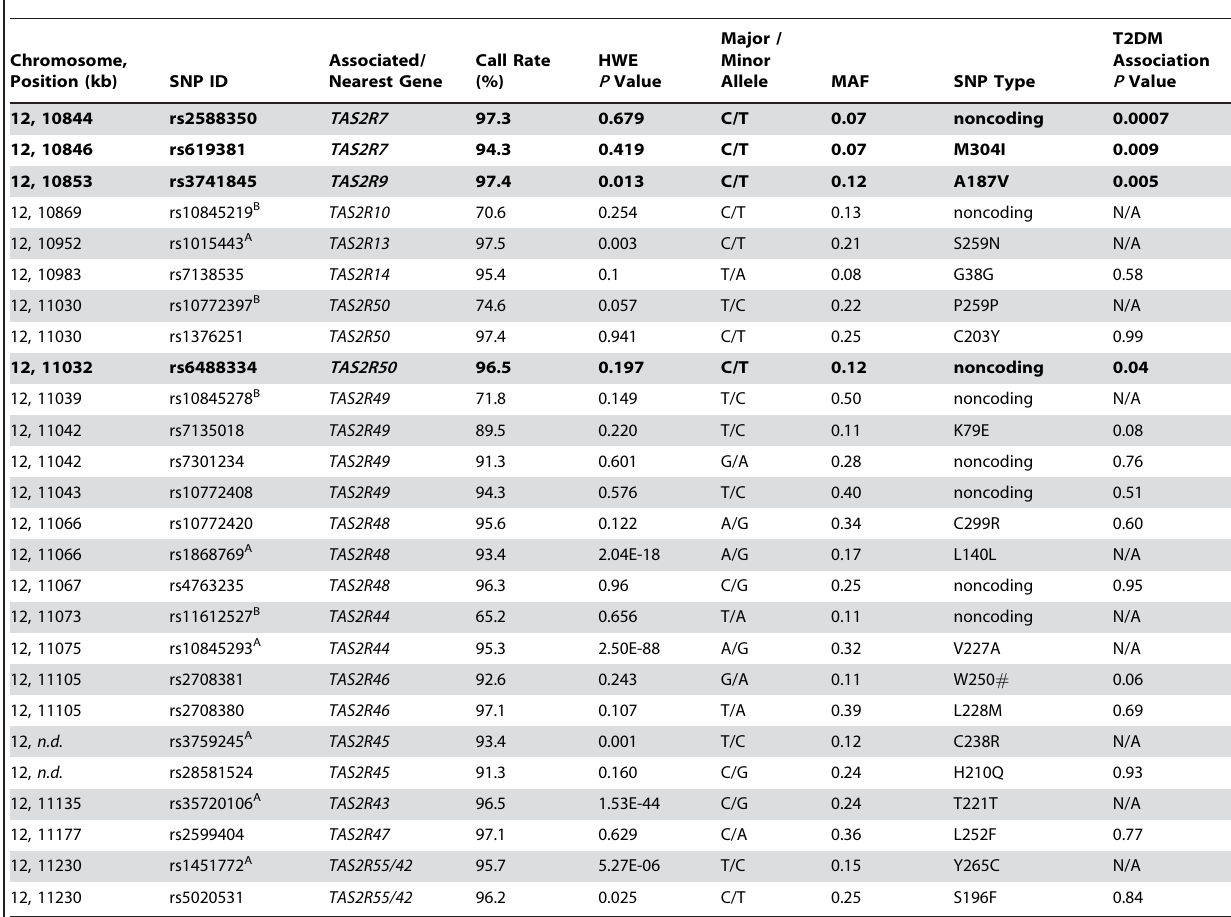
Table 1. Genotyping statistics for chromosome 12 TAS2R SNPs tested in the AFDS.